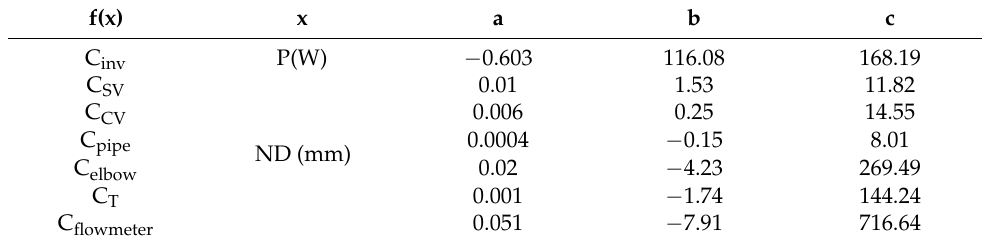
Table 4. Case study coefficients for calculating CAPEX equations.